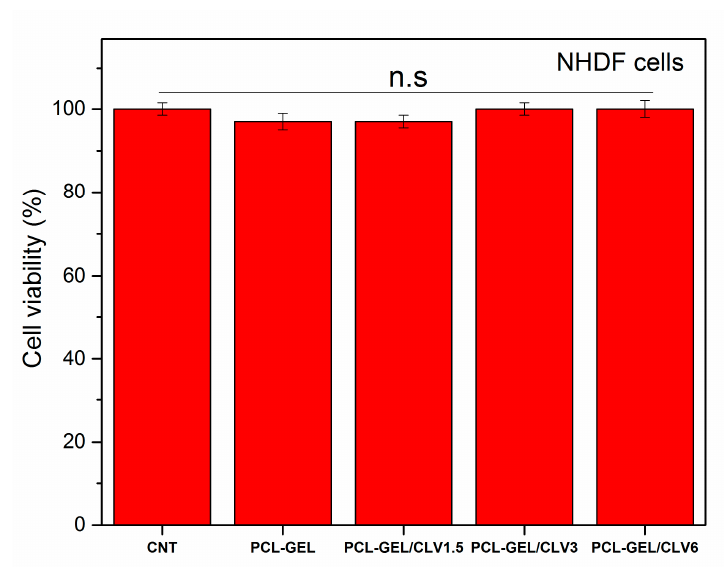
Figure 5. Cell viability percentage of PCL-GEL and CLV-loaded PCL-GEL nanofiber mats after 48